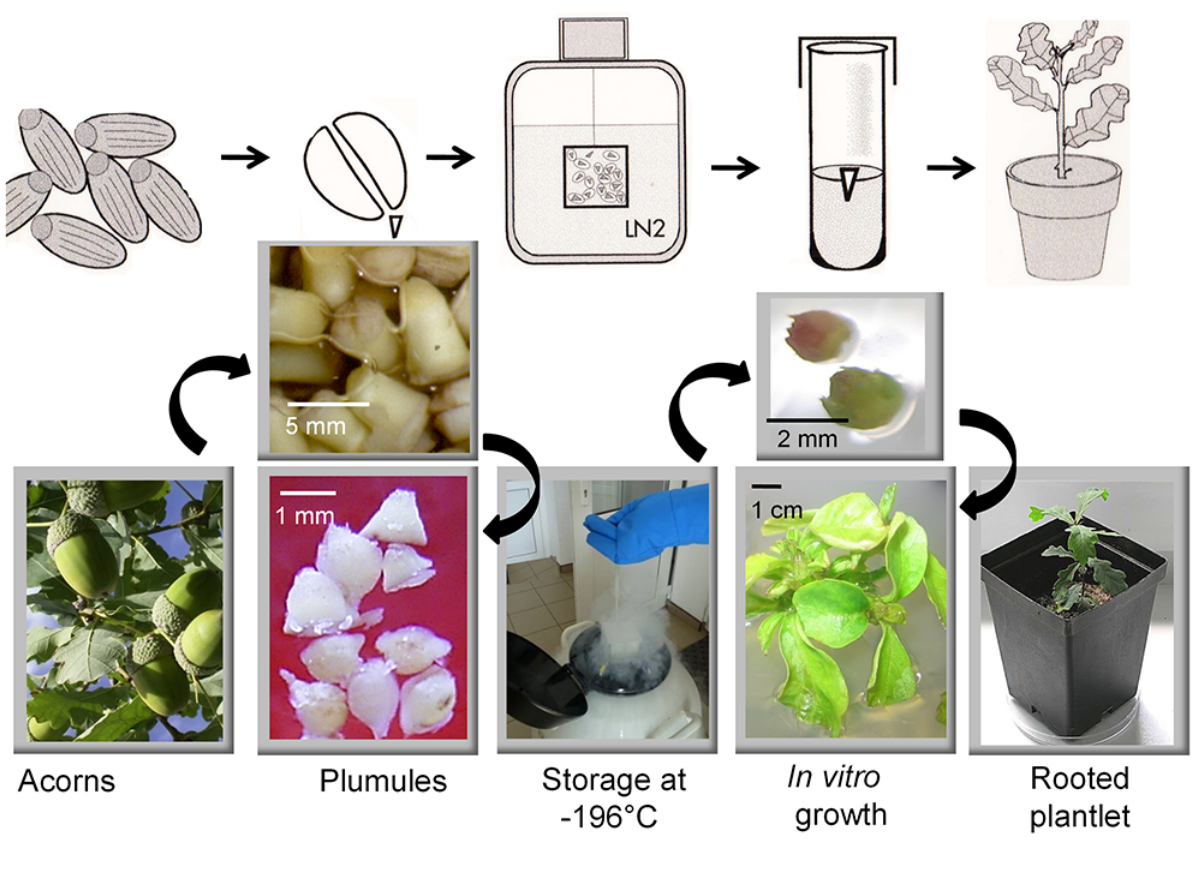
Figure 4 Cryopreservation of Quercus robur plumules. Le to right: Acorns (bottom) from which embryonic axes (EA) were isolated (top); plumules isolated from EA (bottom); Dewar tank for LN storage; plumules recovered in vitro aer LN storage (top); leafy shoots developing from plumules and rooted plantlet (6-month-old) from cryopreservation-derived plumules